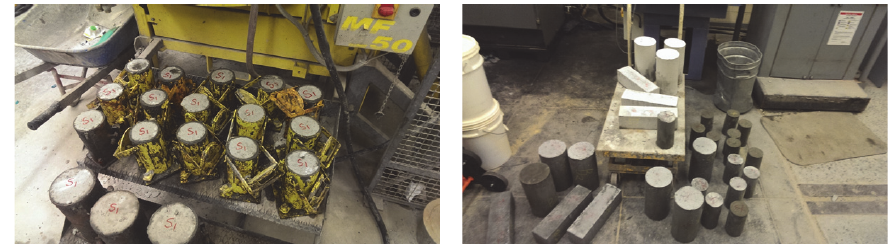
Figure 8: Specimens cast and ready for testing.